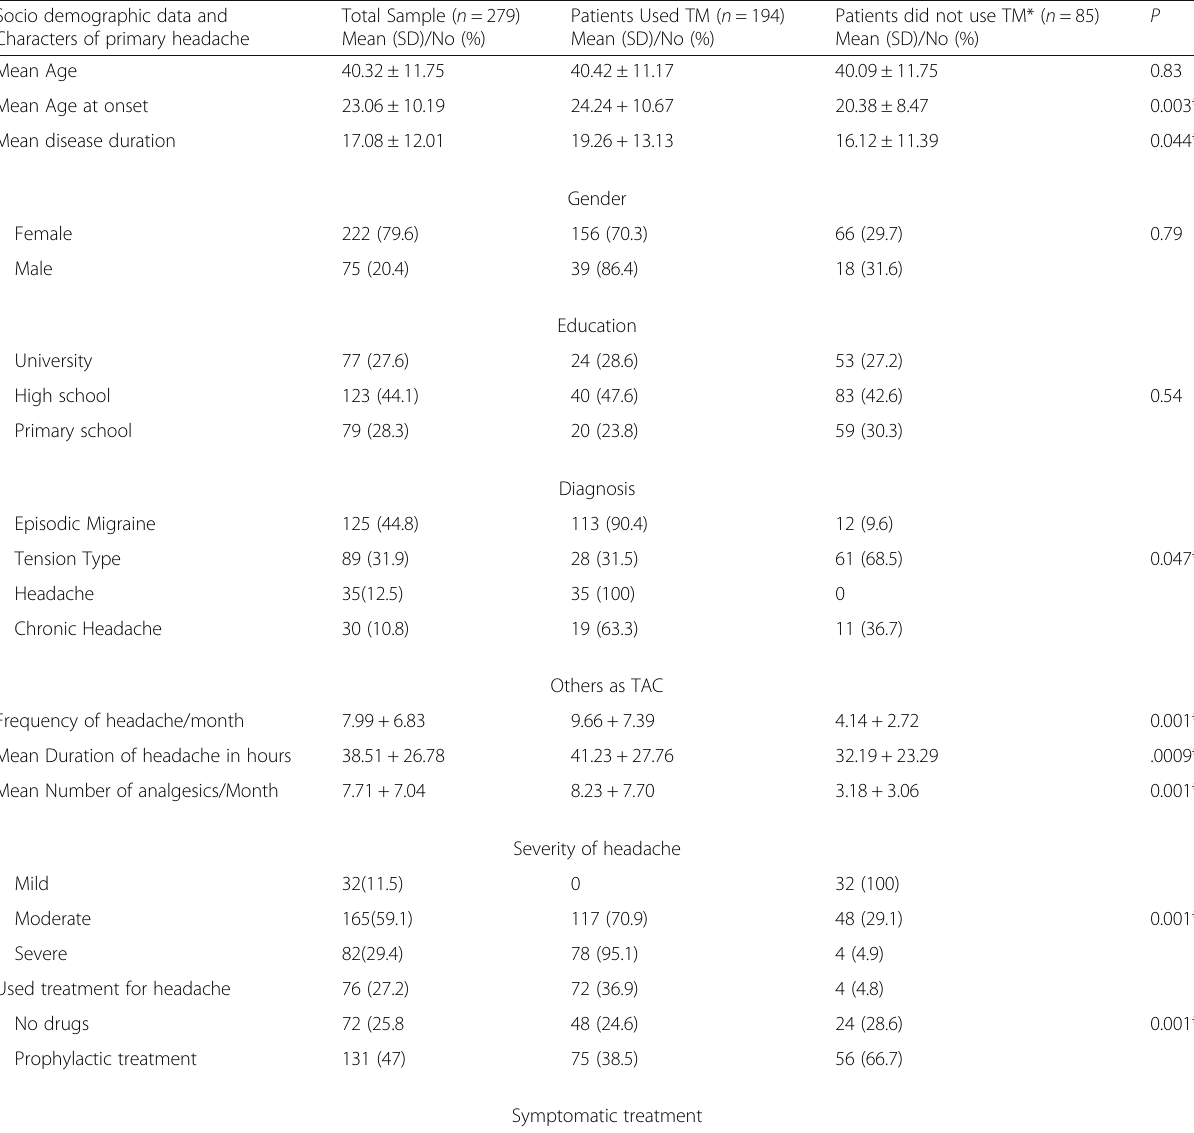
Table 1 Comparison between patient who used TM and who did not use 3 months before presentation to headache clinic Socio demographic data and Characters of primary